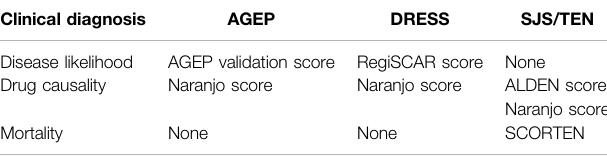
TABLE 1 | Clinical diagnosis and described scoring algorithms. Clinical diagnosis AGEP DRESS SJS/TEN Disease